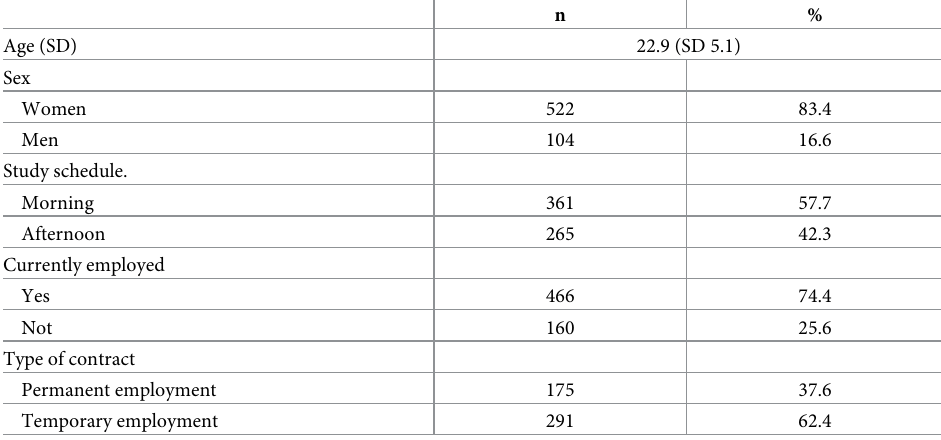
Table 2. Sociodemographic characteristics of the study